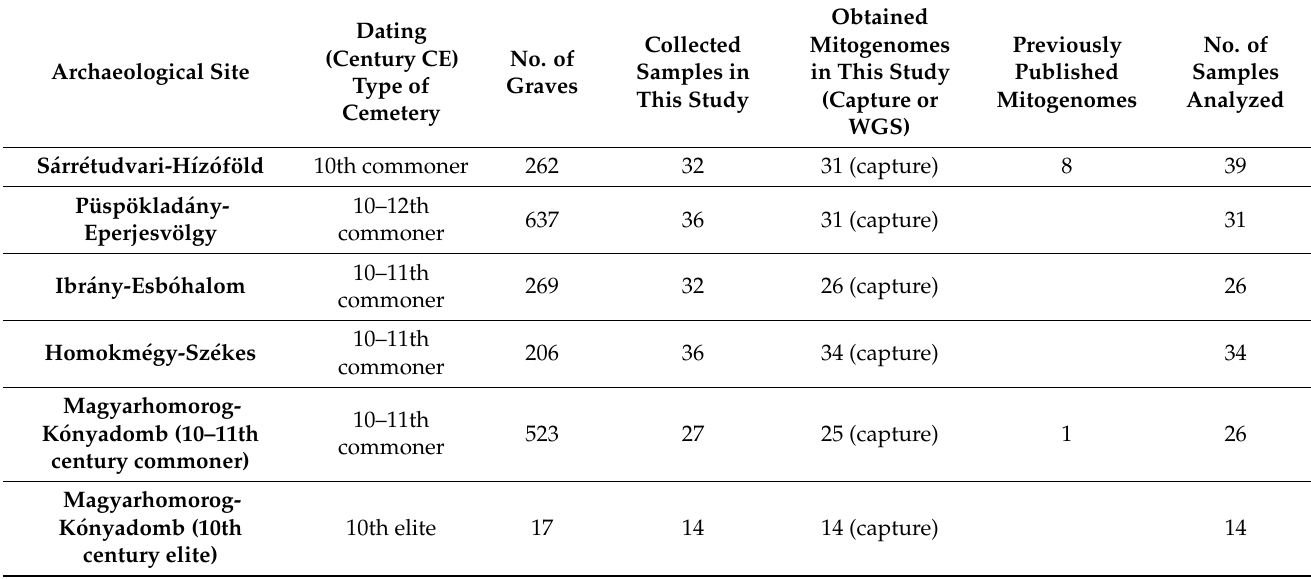
Table 1. Summary of the studied sample size from each cemetery. The mitogenome sequence was obtained after hybridiza- tion capture or whole genome sequencing (WGS) as indicated. Samples represent 10–11th century commoners except 14 samples from Magyarhomorog and 20 samples from Vörs-Papkert B. As indicated, we also co-analyzed 13 previously published mitogenomes with new data from this